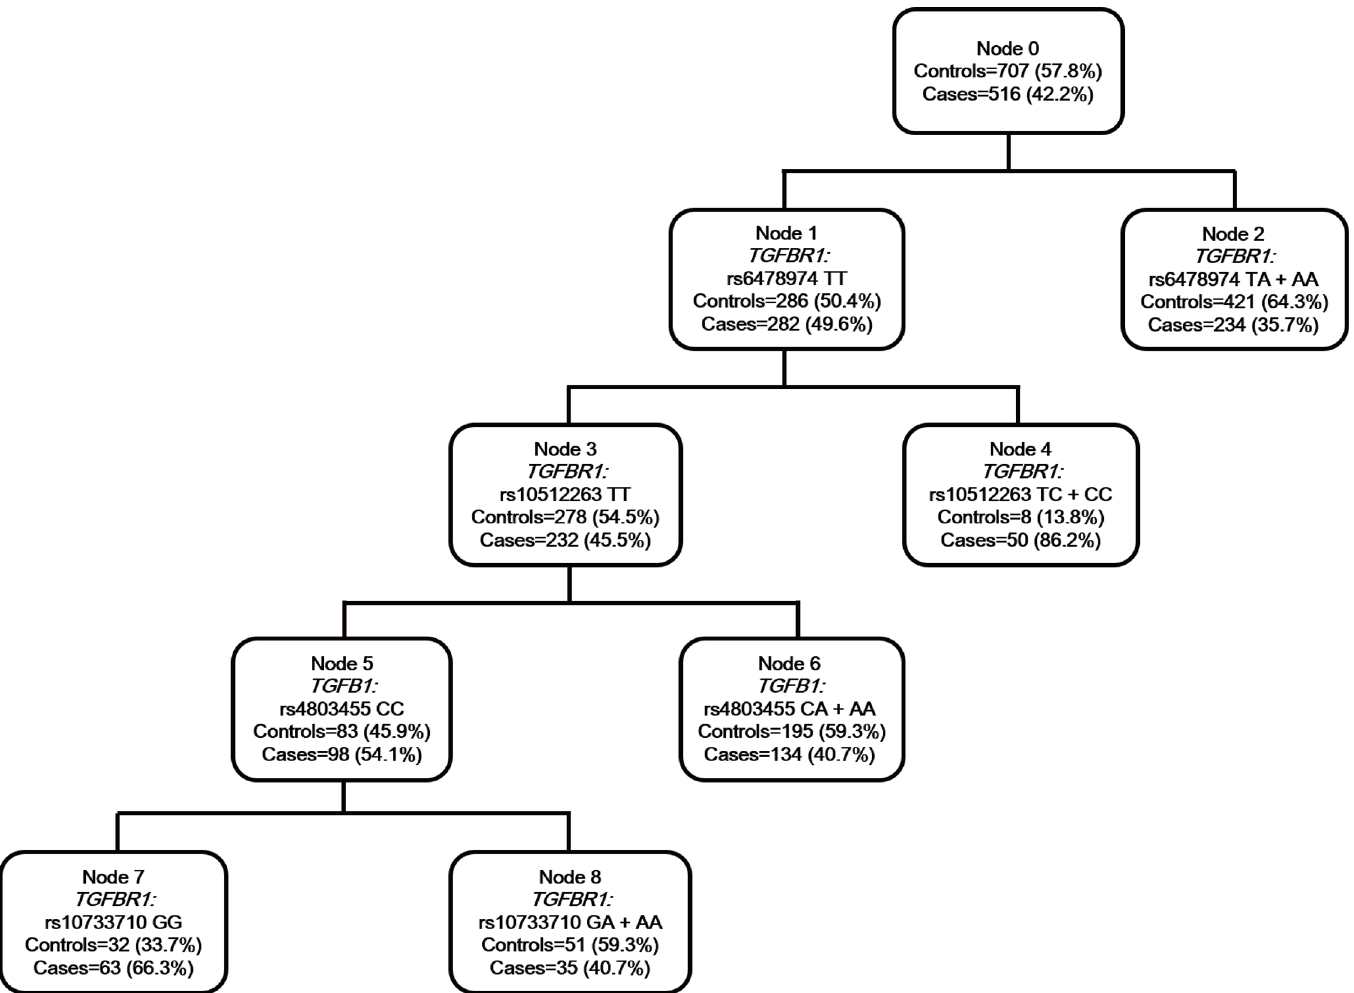
Fig 2. CART analysis of genetic variants in modulating EC